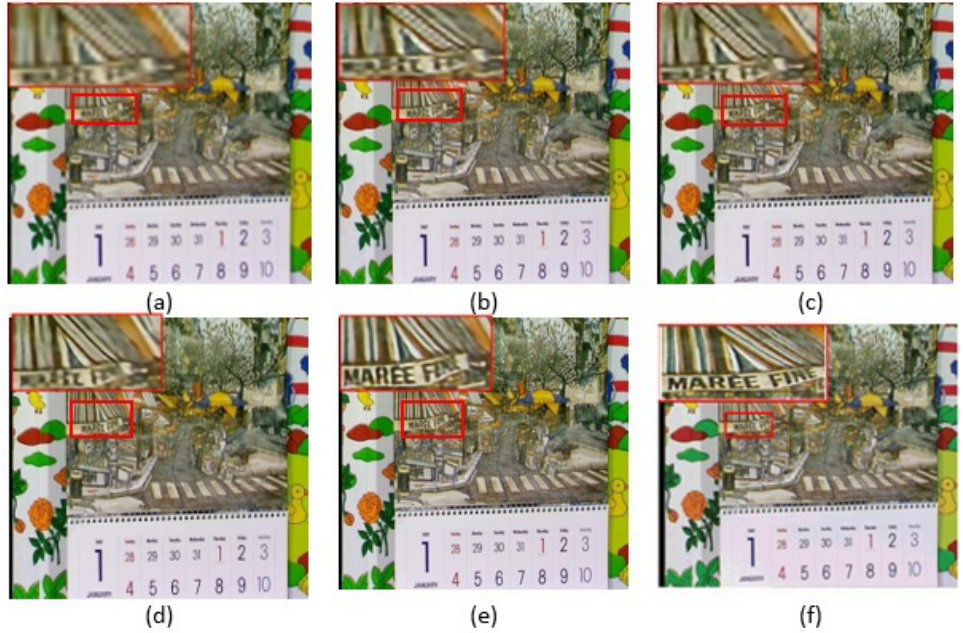
Figure 3. Qualitative comparison between VSR results obtained by ( a ) Bicubic, ( b ) VSRNET [24], ( c ) SRCNN [16], ( d ) VESPCN [27], ( e ) Proposed and ( f ) Ground-Truth on “ calendar ” from Vid4 with scaling factor of